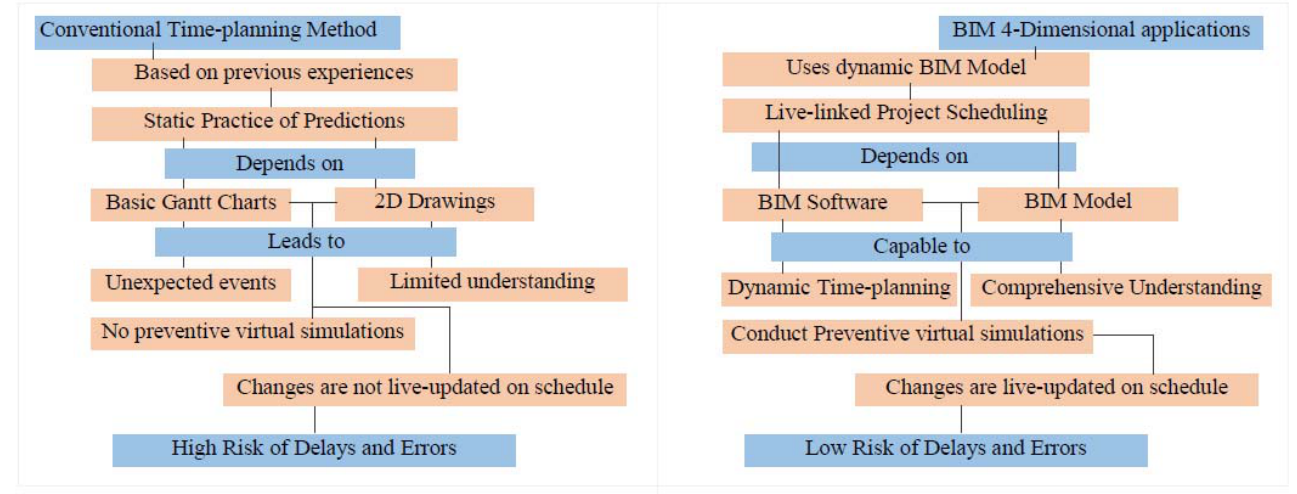
Figure 3. Conventional time-planning method and BIM method.